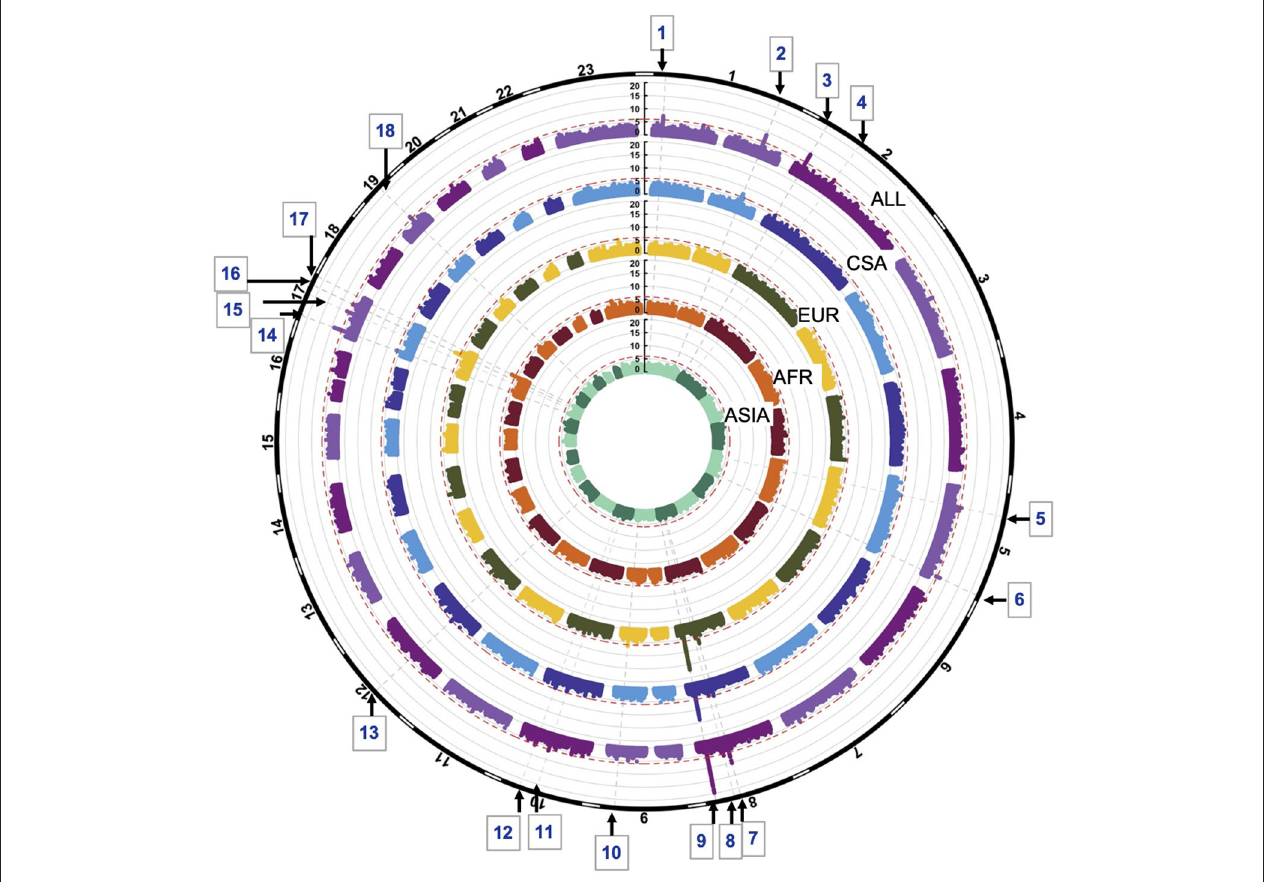
FIGURE 1 | Circular Manhattan plots of ALL, CSA, EUR, AFR and ASIA. Red lines are drawn at the 1e-06 significance level. Loci significant at the 1e-06 significance level are indicated by the gray dotted lines and numbered 1–18. Chromosomes are depicted by the black bands in the outermost